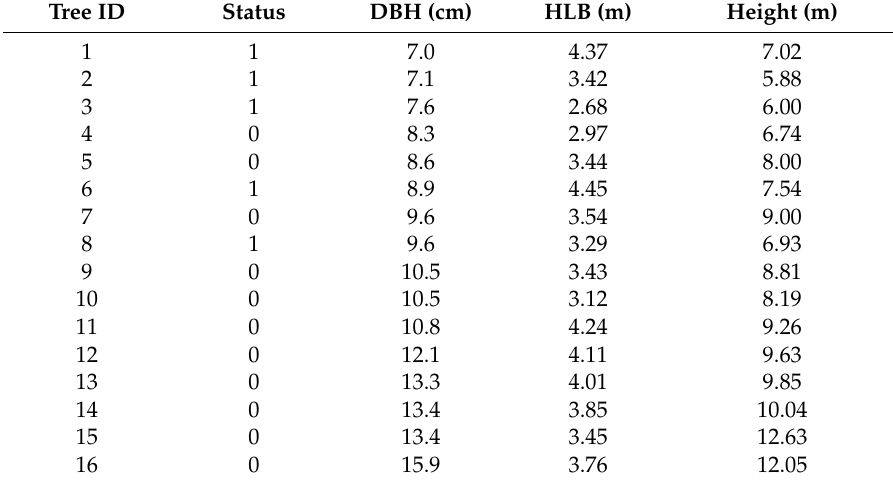
Table A1. Individual sizes of 16 sample trees. Status = 1 represents trees that died between July 2013 and July 2014; otherwise status = 0. DBH, diameter at breast height; HLB, height of the lowest live